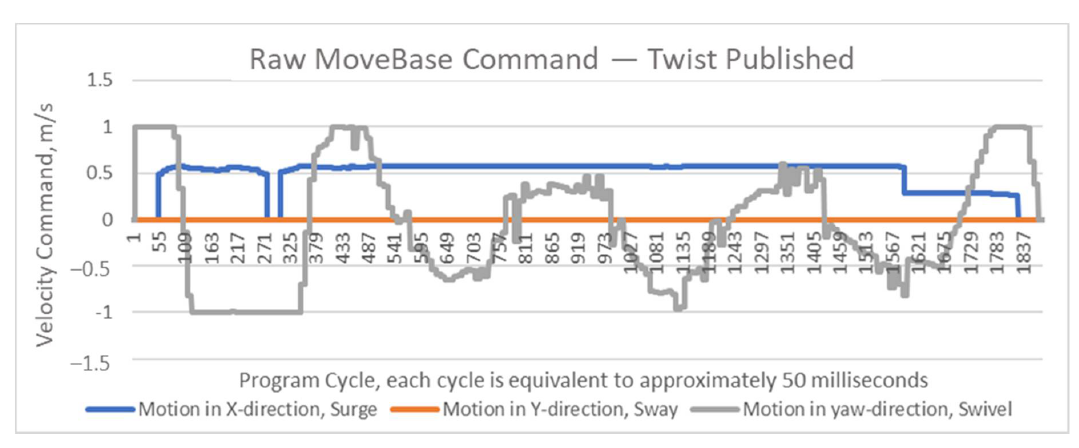
Figure 2. Navigation stack’s move base command pattern.